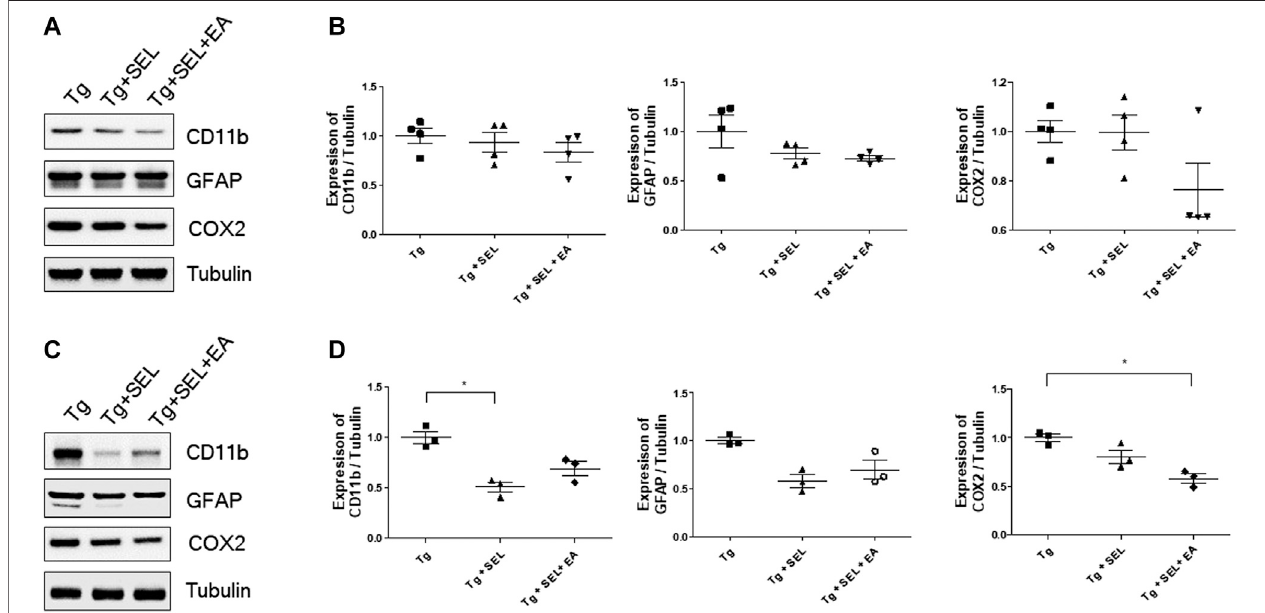
FIGURE 3 | Means ± SEM of CD11B, GFAP, and COX2 for Tg, Tg + SEL, and Tg + SEL + EA mice groups. (A) Representative immunoblot images from the hippocampi. (B) Quanti fi cationofexpressionlevelsinthehippocampi(n (cid:2) 4/group). (C) Representativeimmunoblot imagesfromtheprefrontalcortex. (D) Quanti fi cation ofexpressionlevelsintheprefrontalcortex(n (cid:2) 3/group).StatisticalanalysisoftheimmunoblotswasanalyzedusingKruskal – WallistestandDunn ’ smultiplecomparison test with p values < 0.05 considered statistically signi fi cant. SEM, standard error of mean; Tg, 5XFAD mice group; Tg + SEL, selegiline-treated 5XFAD mice group; Tg + SEL + EA, 5XFAD mice group treated with selegiline combined with electroacupuncture.